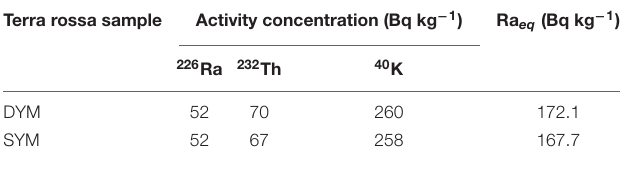
TABLE 2 | Activity concentrations of 226 Ra, 232 Th, and 40 K (Bq kg − 1 ) together